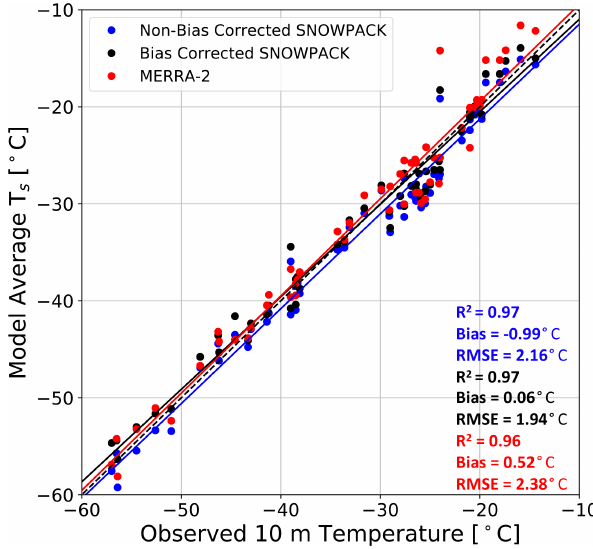
Figure 3. Modeled surface temperature evaluation. Comparison be- tween observed borehole 10m depth temperature ( ◦ C) and 1980– 2017 model-average non-bias-corrected SNOWPACK (blue), bias- corrected SNOWPACK (black), and MERRA-2 (red) surface tem- perature T s ( ◦ C). The dashed black line represents a one-to-one line. Solid lines represent linear regressions. R -squared values, mean bias, and RMSE are reported for non-bias-corrected SNOWPACK (blue text), bias-corrected SNOWPACK (black text), and MERRA- 2 (red